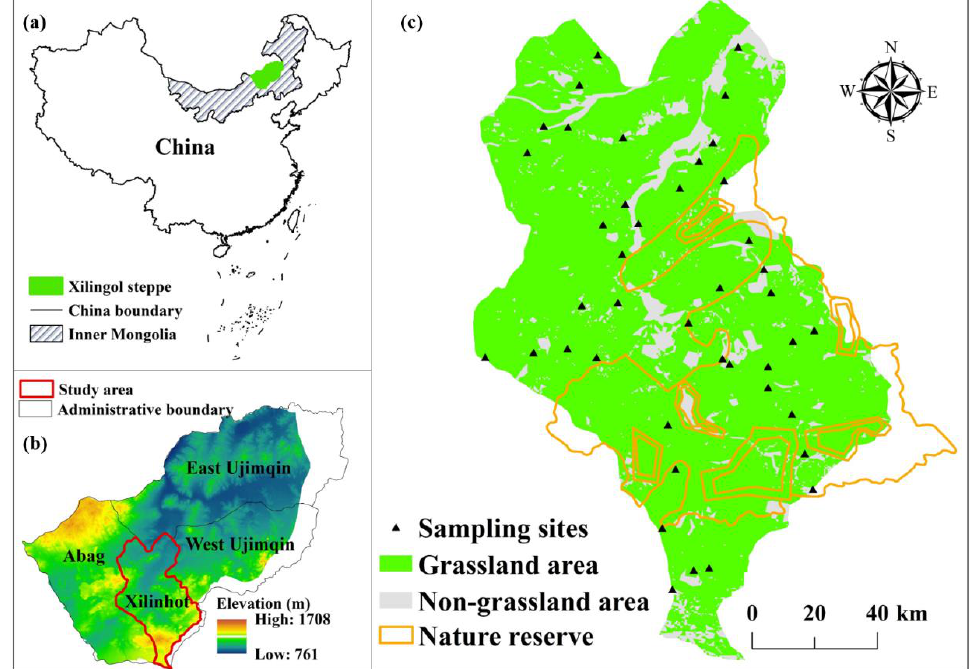
Figure 1. The location of the study area. ( a ) The location of the study area relative to China; ( b ) the location of the study area relative to Xilingol typical steppe; ( c ) the scope of study area and sampling sites. The nature reserve is the Xilingol Grassland National Nature Reserve.